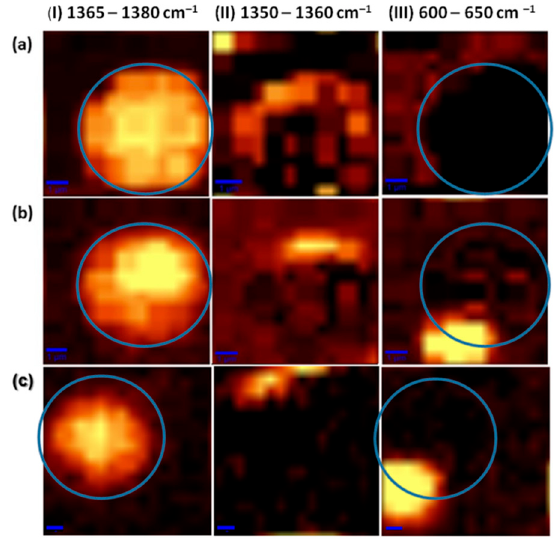
Figure 3. Raman mapping of individual RBC: ( a ) control RBC; ( b ) RBC with TiO 2 (Rutile); and ( c ) RBC with TiO 2 (Anatase). (I) mapping in the range of 1365–1380 cm − 1 shows distribution of oxyHb; (II) mapping in the range 1350–1360 cm − 1 shows the distribution of deoxyHb; and (III) mapping in the range 600–650 cm − 1 shows the distribution of the TiO 2 peaks only in the TiO 2 -treated RBC. The spectra were collected at ambient conditions, 488 nm wavelength laser excitation; 24 × 24 pixels. Scale bar is 1 μ m. The RBC contour in mapping of TiO 2 in (III) is marked according to the cell mapping in (I).